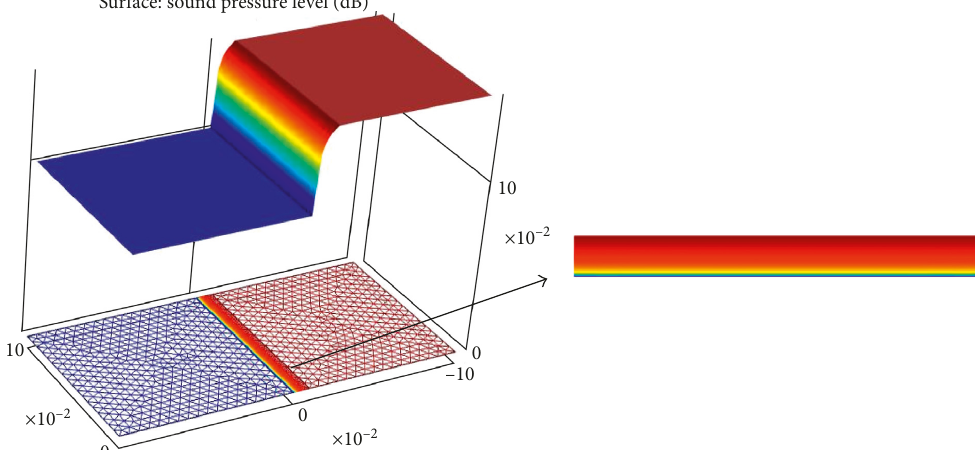
Figure 10: FEM model with the gypsum sample.